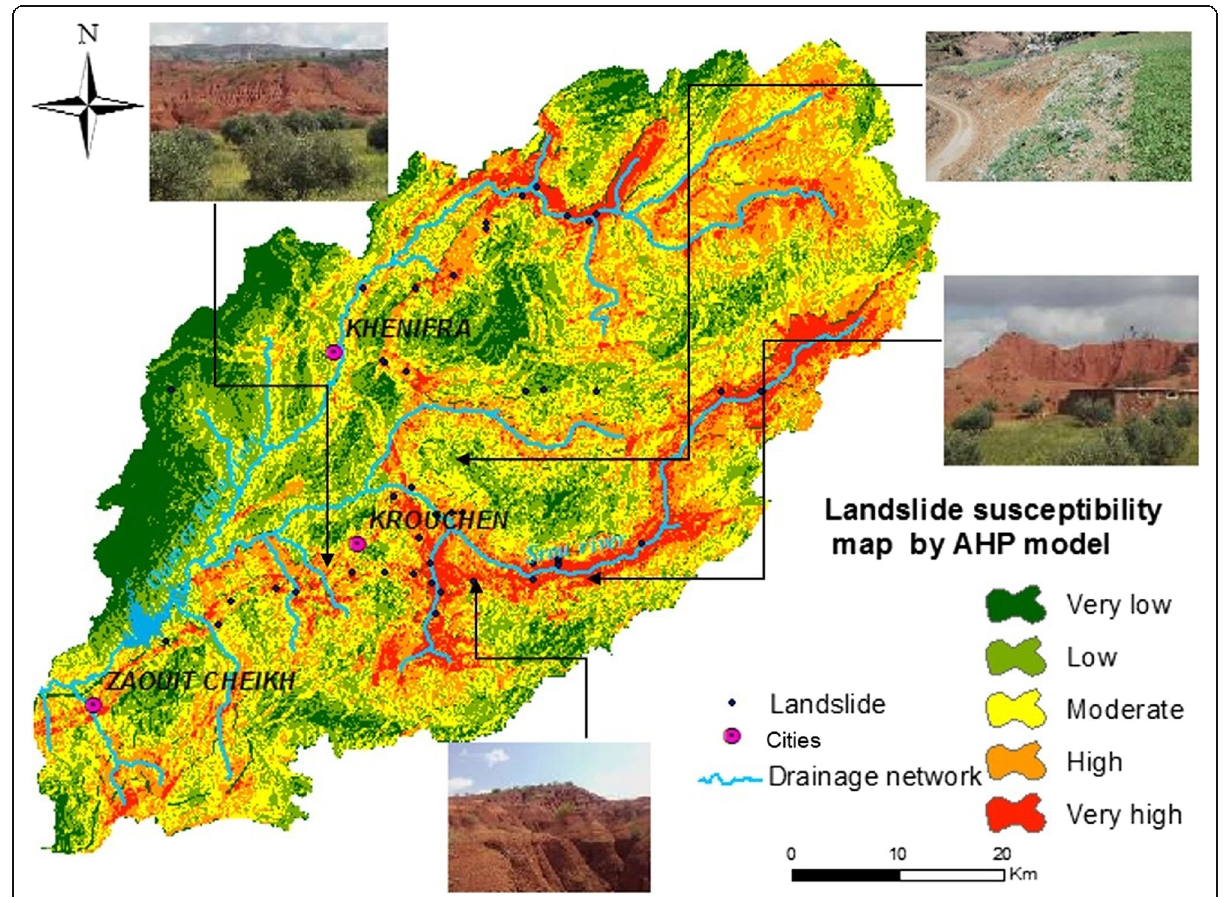
Fig. 4 Landslide susceptibility map based on AHP model